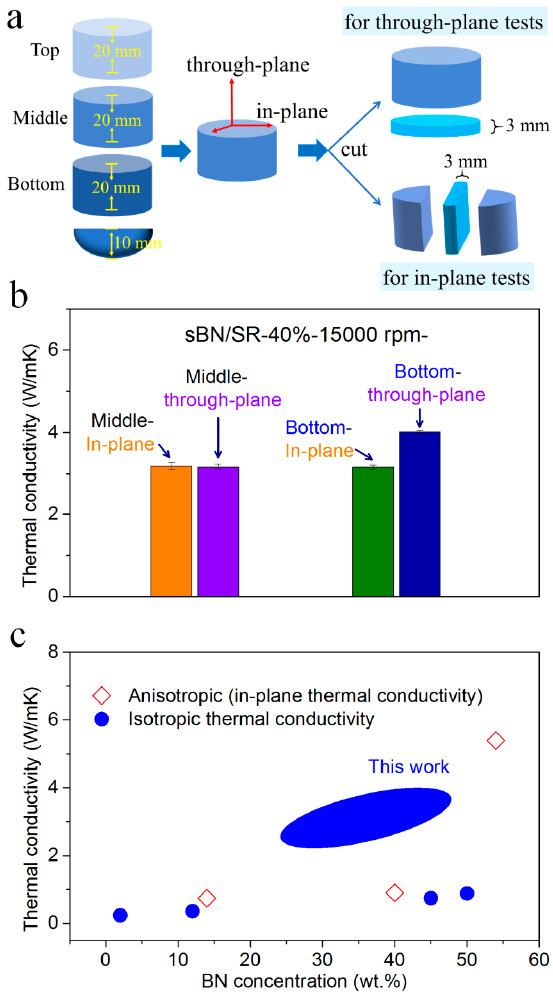
Figure 8. ( a ) Scheme diagram of the samples for through ‐ plane and in ‐ plane thermal conductivity tests. ( b ) The thermal conductivity in different parts and different directions of sBN/SR ‐ 40% ‐ 15,000 rpm composites. ( c ) Comparison between the thermal conductivity of BN/SR composites in the literature and in this